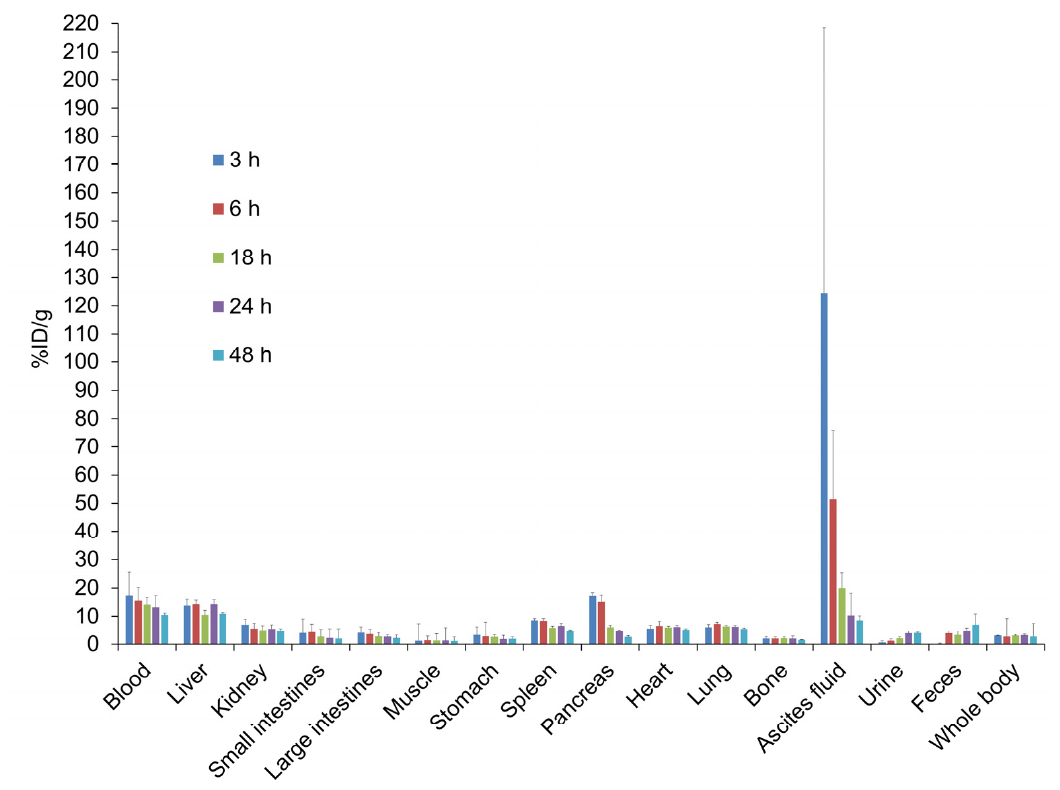
Figure 3. Biodistribution of the intraperitoneally administrated 64 Cu-NCAB001 in mice ( n = 4). Data are shown as the %injected dose (ID)/g for the organs, blood, and ascites fluid, and the %ID for the urine and feces.